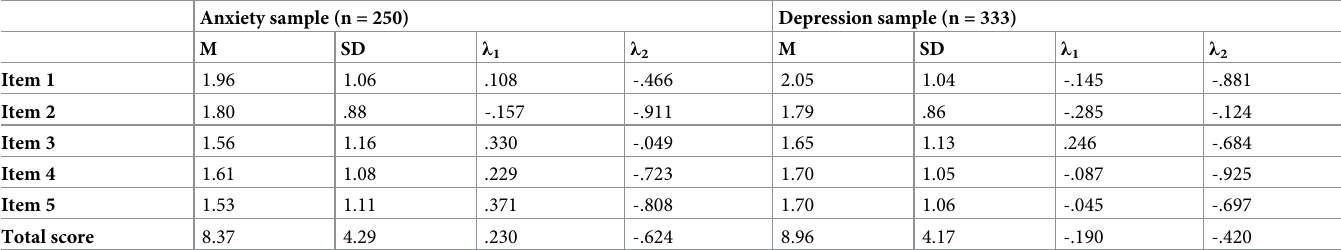
Table 2. Descriptive statistics for each item and the total score on the OASIS in depressive and anxiety disorder samples. Anxiety sample (n = 250)